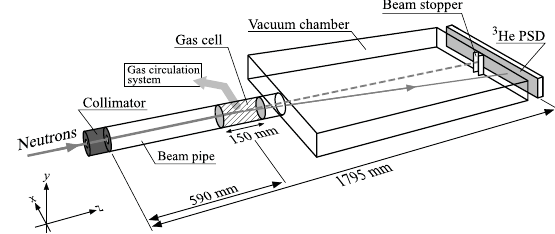
Figure 1. Layout of our experiment as mounted on BL05 at the MLF facility at J-PARC. Image taken from [5].